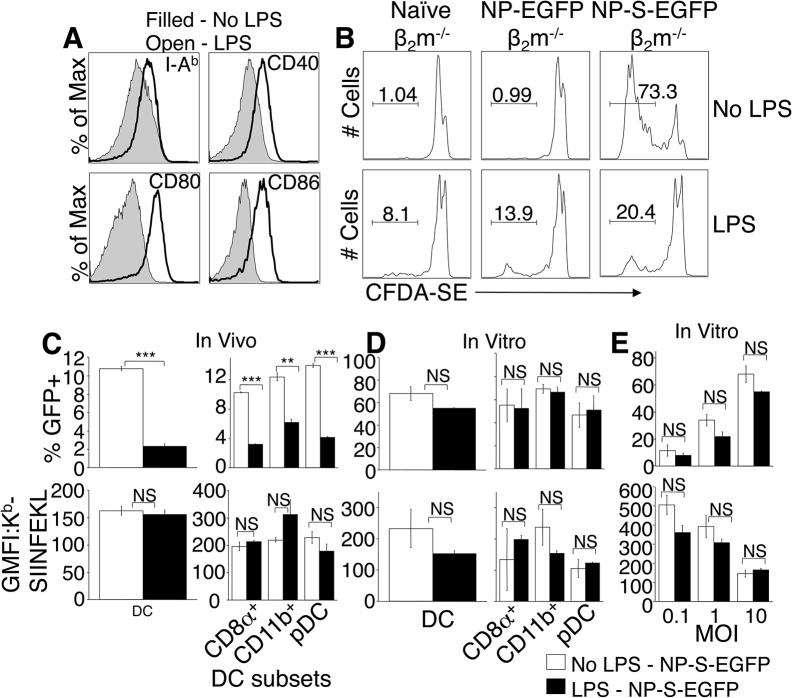
Treatment with TLR agonists in vivo inhibits viral infectivity but does not enhance direct antigen presentation.(A) Mice were injected i.v. with LPS, and 12 hr later splenocytes stained to identify DC, and examine expression of MHC class II, CD40, CD80, and CD86. Representative of 3 experiments, using 3 mice per condition. (B) CFDA-SE-labeled OTI TCD8+ were adoptively transferred into mice that were then treated with LPS i.v. and 12 hours later injected i.p. with β2m-/- cells infected with NP-EGFP or NP-S-EGFP as above. Three days later, OTI TCD8+ cell proliferation was determined by CFDA-SE dye dilution. Nos. represent % of cells representative of 3 experiments, using 3 mice per condition. (C) Mice were injected with LPS as above, and 12 h later, the mice were infected i.v with NP-S-EGFP. Twelve h.p.i., splenocytes were stained for DC subsets. Graphs depict ECTV-infection of DC (top panel, left) or DC subsets (top panel, right), and direct presentation by DC (bottom panel, left) or DC subsets (bottom panel, right). Data are pooled from 3 experiments, using 3 mice per condition (mean ± standard error). (D) Splenocytes were harvested and treated with LPS for 12 h, then infected with NP-S-EGFP (MOI = 10). Twelve h.p.i., cells were stained as described in (C). Graphs depict ECTV-infection of DC (top panel, left) or DC subsets (top panel, right), and direct presentation by DC (bottom panel, left) or DC subsets (bottom panel, right). Data are pooled from 3 experiments, using 3 mice per condition (mean ± standard error). (E) Splenocytes were treated with LPS for 12 h, then infected with NP-S-EGFP at the MOI indicated. Graphs depict infection of DC (top panel) and direct presentation by DC (bottom panel). Data are representative of two independent experiments (mean ± standard dev). P values *p<0.05, **p<0.01, ***p<0.001, NS (not significant). Student’s unpaired t-test.